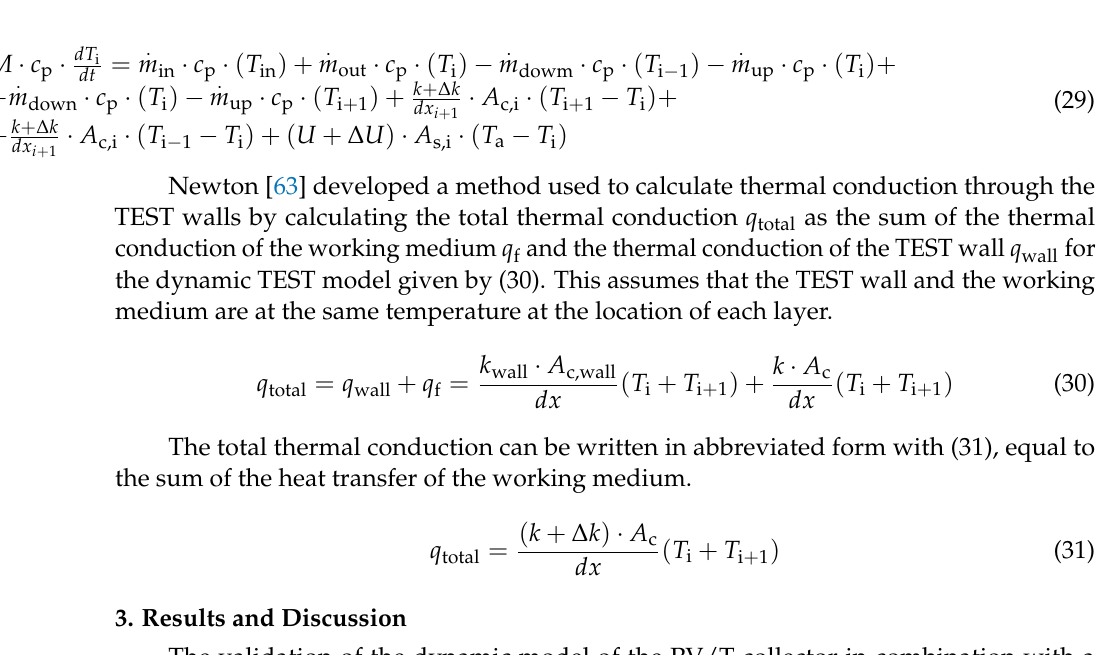
Figure 7. Temperature measurements of the working medium within the TEST at six different heights for 83 days (from August to October 2021). In the dynamic model of the PV/T collector, the input of the thermal properties of the working medium (mixture of glycol and water) appears in (21 – 24). The thermal properties of solid materials do not change significantly depending on low temperatures. In contrast to the working medium, which occurs in the liquid state, the thermal properties (such as density, specific heat, thermal conductivity, kinematic viscosity, and Prandtl number)